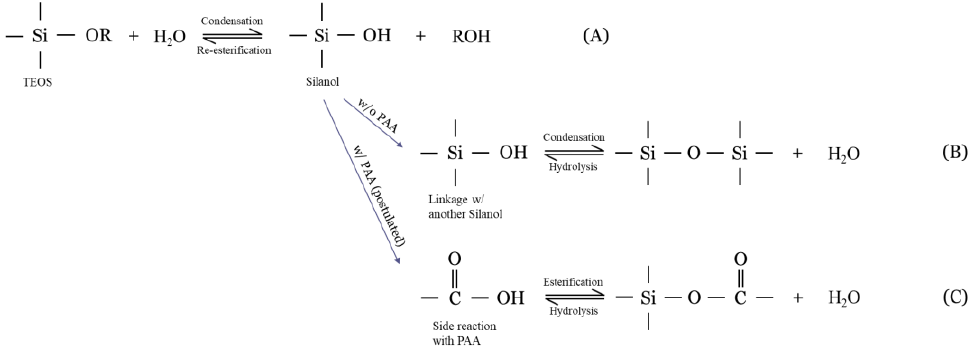
Figure 10. Reaction mechanisms of forming hydrophobic films at with and without PAA: ( A ) silanol-forming reactions; ( B ) formation of Si-O-Si structure at no PAA addition; ( C ) formation of Si-O-CO structure at the presence of PAA (postulated).